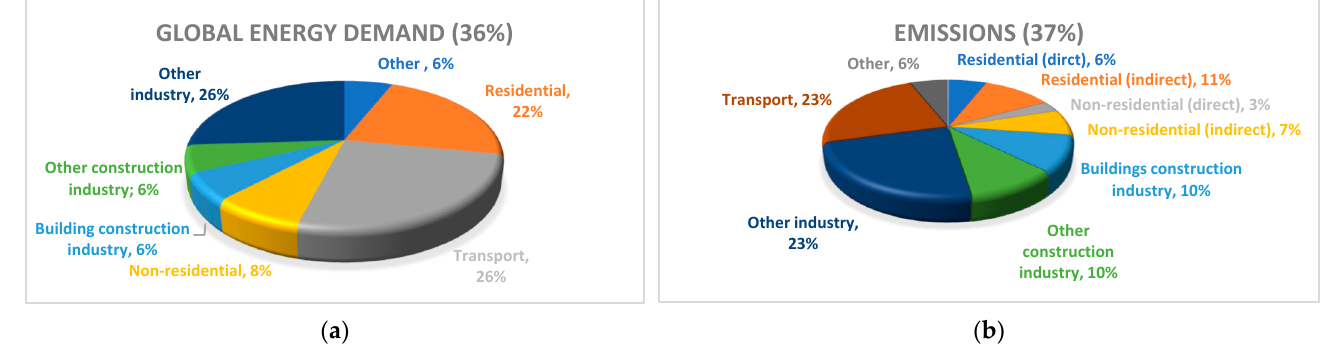
Figure 1. ( a ) Global share of buildings and construction final energy; ( b ) buildings and construction’s share of global energy-related CO 2 emissions; 2020 [2].